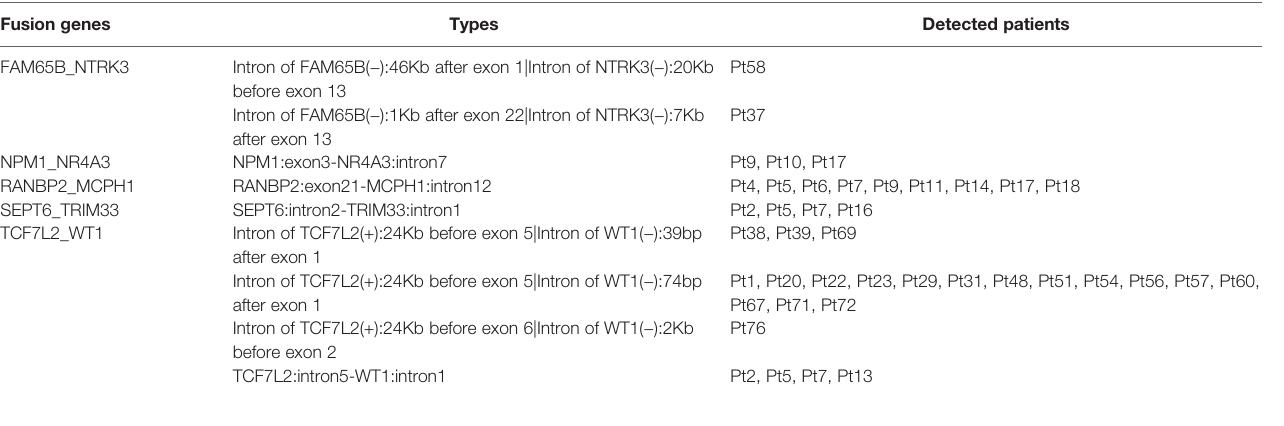
TABLE 2 | Fusion genes identi fi ed from79 B-cell lymphomas. Fusion genes